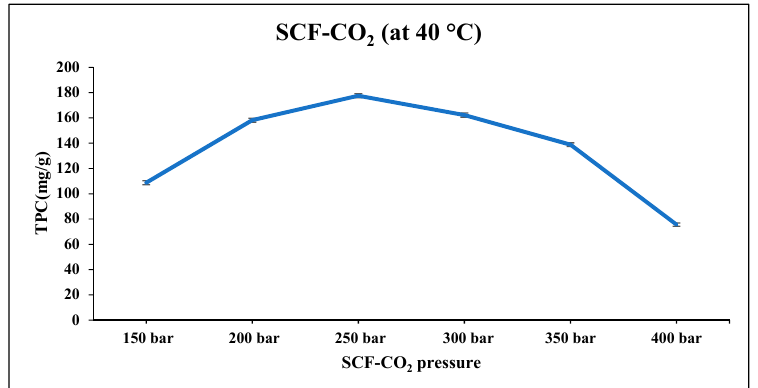
Figure 3. Effect of SCF-CO 2 co-solvent pressure on TPC of CJPD .